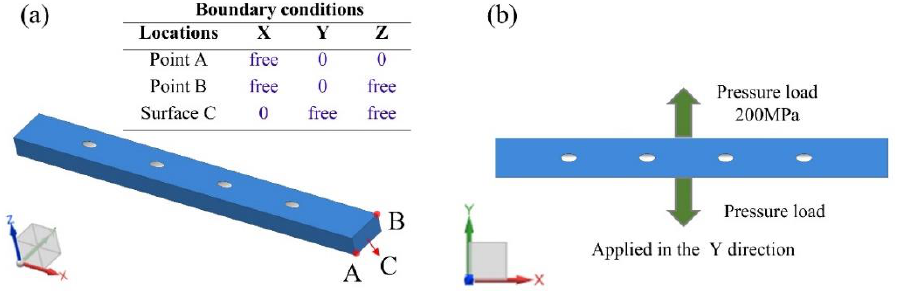
Figure 5. Boundary conditions for ( a ) thermal stress and ( b ) thermomechanical stress under 200 MPa.